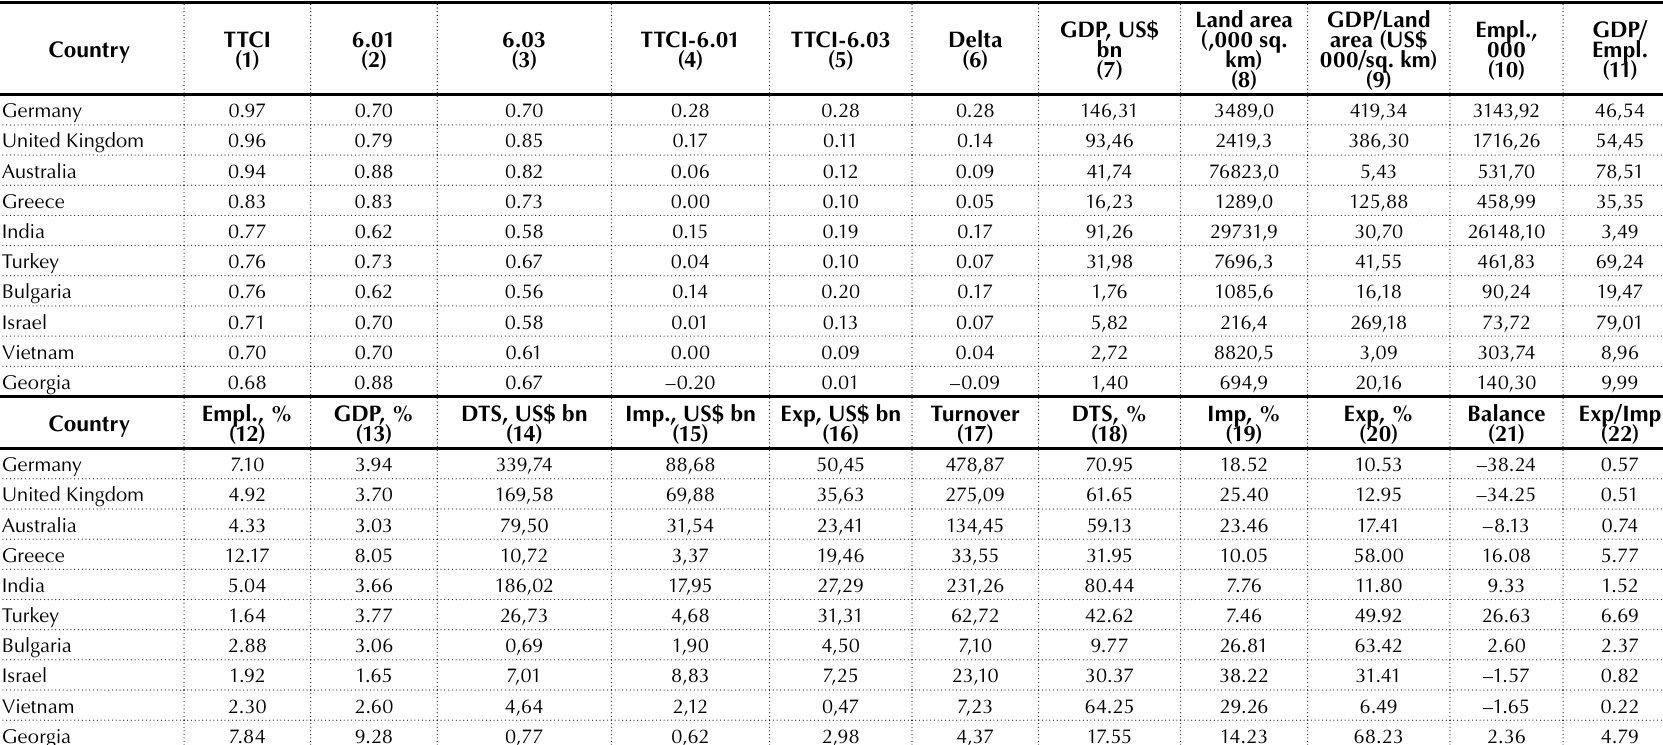
Table 1. Macroeconomic indicators of the national tourism industry (the sample hard data and calculated indicators*), 2017 or the last available